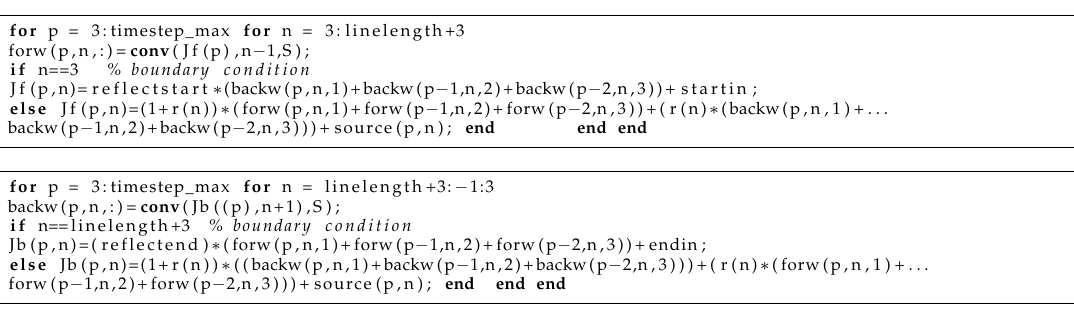
Figure 2. MATLAB style code showing the calculation of the backward (left) propagating variable in the impulse response calculation. p is the timestep, n is the node and S is the weighting function.